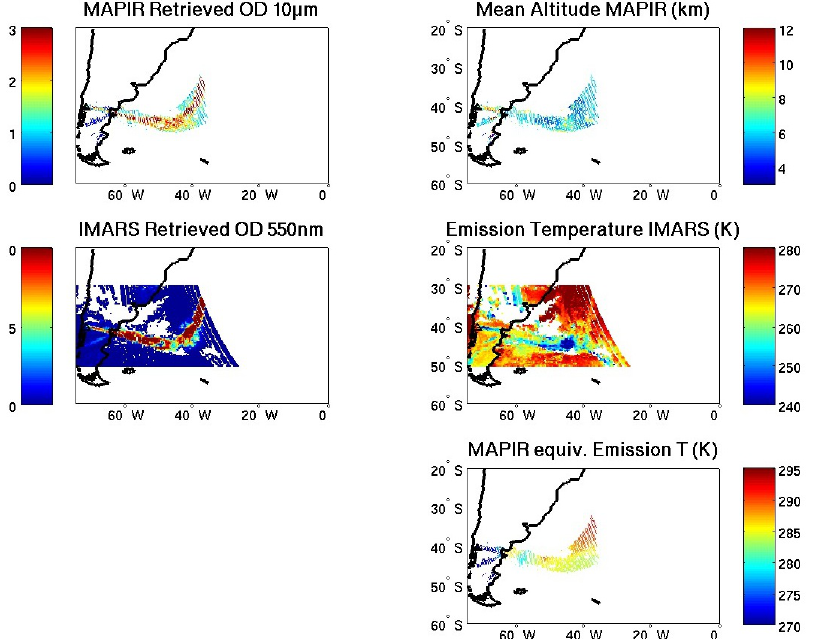
Figure 9. Comparison between MAPIR (presented in this paper) and IMARS (updated from [31]) for the 5 June 2011, local evening. The retrievals are presented in terms of AOD and mean altitude information (in the form of emission temperature for the IMARS product).